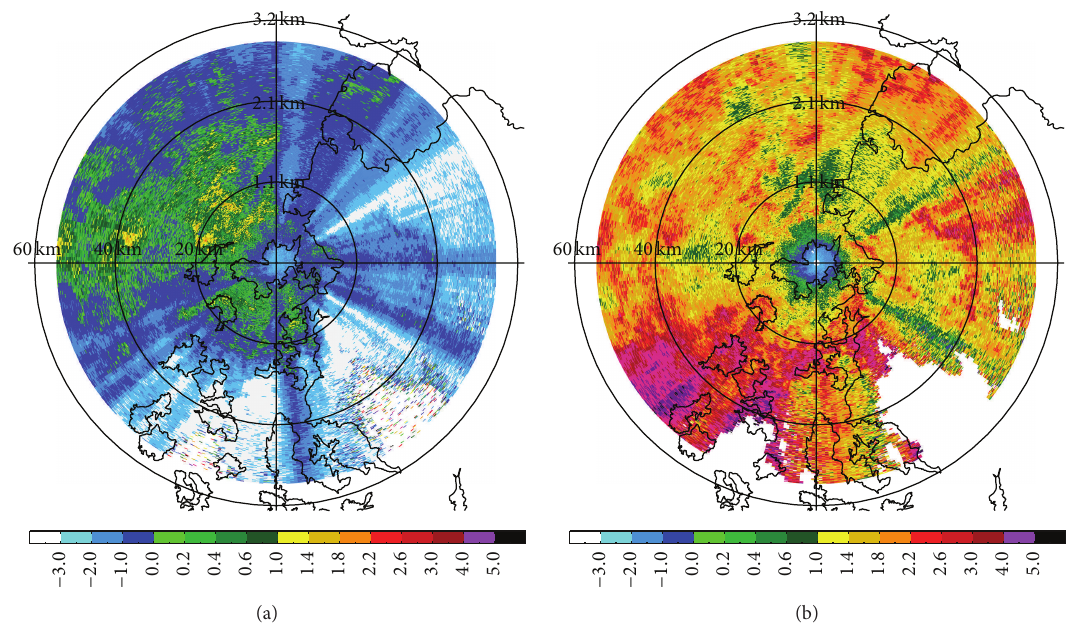
Figure 9: PPIs of measured (a) and attenuation corrected (b) 𝑍